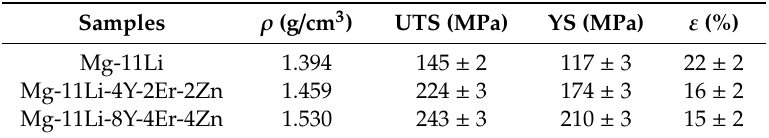
Figure 9. Tensile stress–strain curves of the as-extruded Mg-11Li-based alloys. Table 2. Average tensile properties including ultimate tensile strength (UTS), yield strength (YS), and ε of the studied alloys.